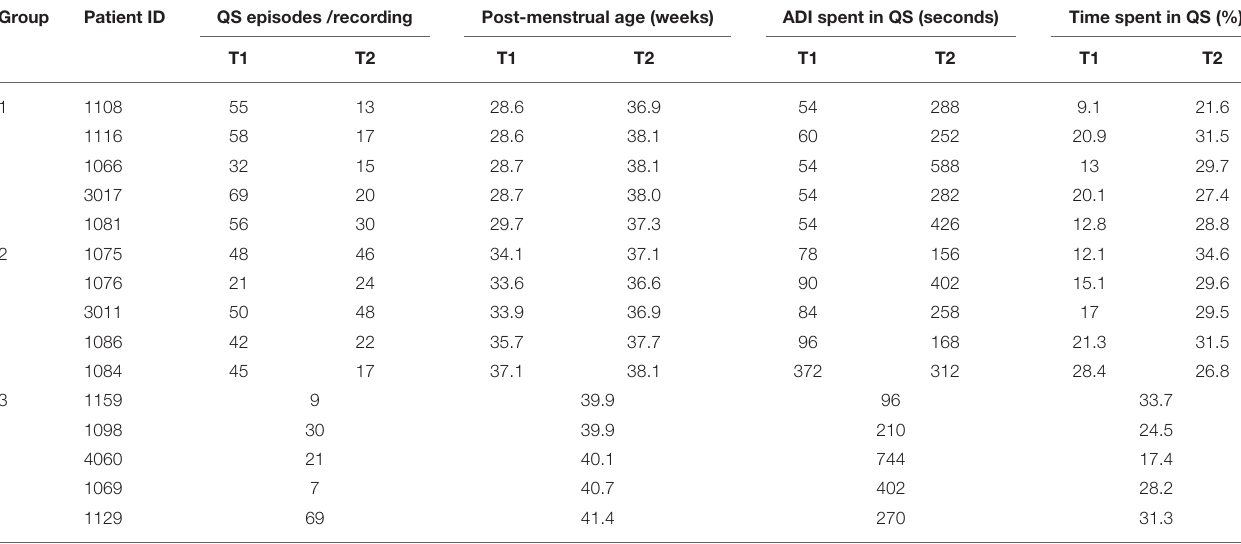
TABLE 2 | Average duration of quiet sleep intervals and percentage of time spent in quiet sleep.